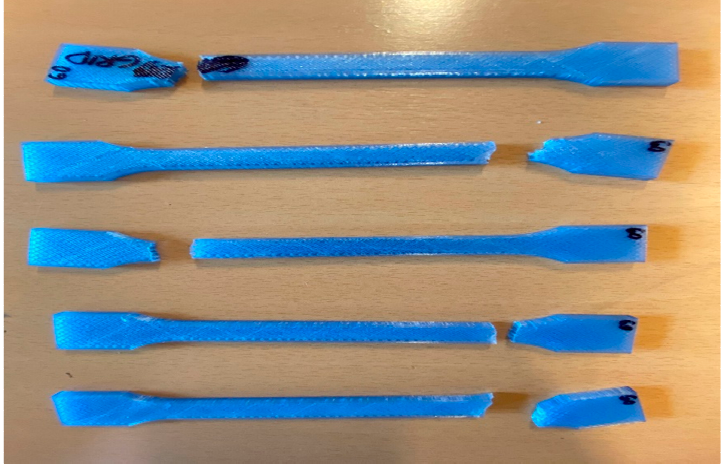
Figure 4. Sample of specimens after the tensile test (virgin PET). Tensile properties including tensile yield strength and tensile modulus of elasticity were cited in Table 4. Table 4. Tensile properties of virgin versus recycled polyethylene terephthalate 3D printed speci- mens.